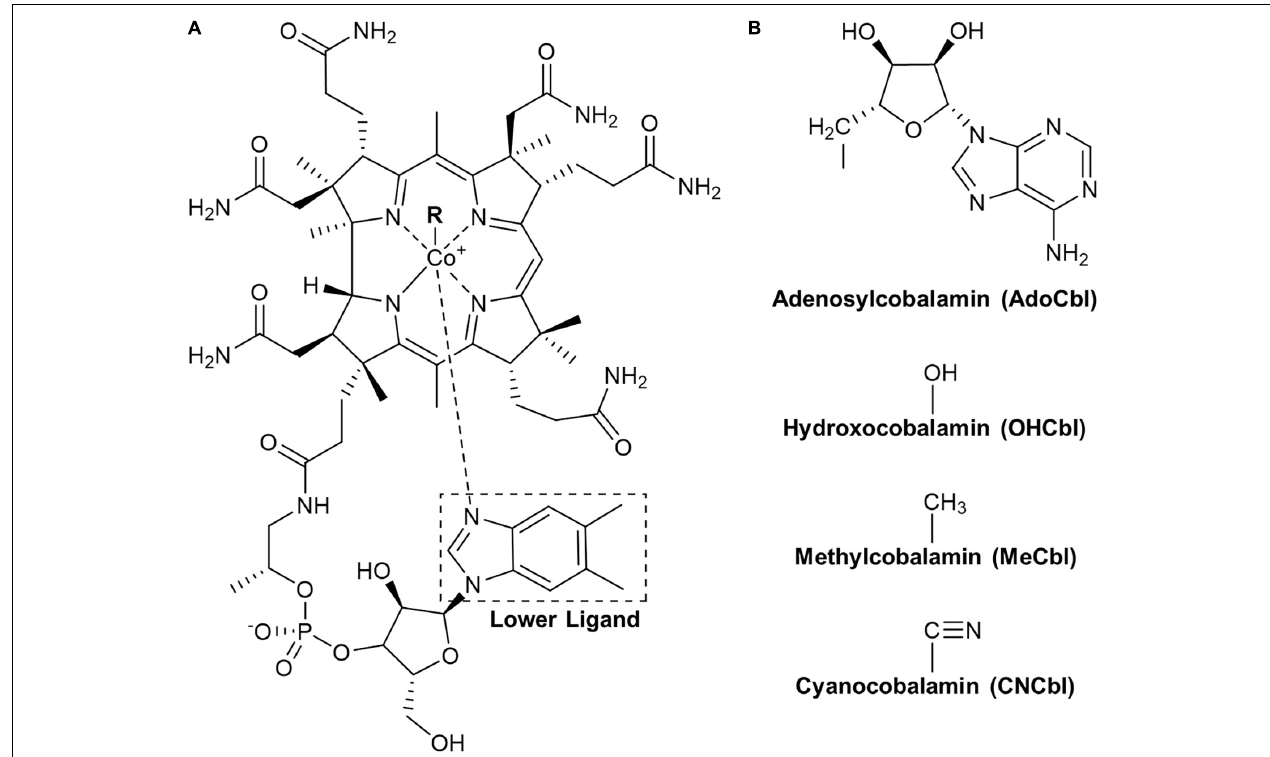
FIGURE 1 | The cobalamin structure. (A) Core structure of the cobalamin with the lower ligand 5,6-dimethylbenzimidazole (DMB) indicated by the box. (B) Structures of upper ligands (R) for individual vitamers with corresponding names and abbreviations given below.